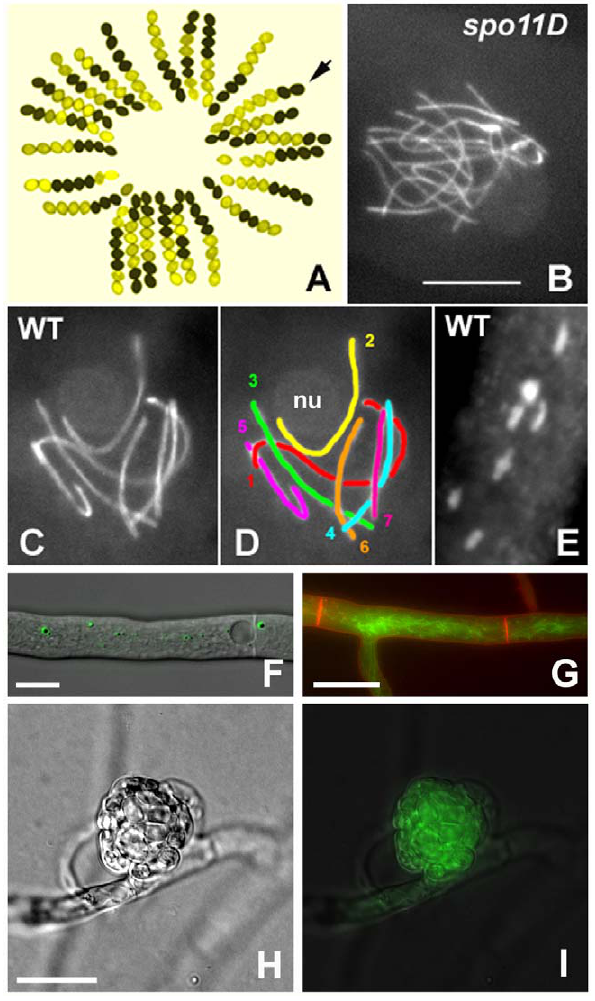
Figure 1. S.macrospora as a model organism for the analysis of meiosis and fruiting body development. (A) Segregation of the ascospore-color mutant pam2 from a cross; wild type (black ascospores) by pam2 (yellow ascospores). Arrow points to a gene conversion indicated by two black and six yellow ascospores. (B–D) Meiotic prophase. Chromosome axes are stained by the cohesin-associated Spo76/Pds5 protein tagged with GFP. (B) Prophase nucleus of a spo11 null mutant: the 14 chromosomes do not align or synapse and this asynaptic status is seen from leptotene through pachytene. (C, D) Pachytene nucleus from wild-type Sordaria: the seven bivalents are differentiated by their size (D). Chromosome 2 (yellow), which bears the nucleolar organizing region, is attached to the nucleolus (nu). (E) The seven bivalents at late diplotene, stained by DAPI. Note the difference in size when compared to the pachytene nucleus. Bar (B–E)=5 m m. (F) An EGFP-HEX1 fusion protein localizes to Woronin bodies. Bar=10 m m. (G) The GFP-tagged developmental protein PRO41 localizes to the endoplasmic reticulum. Plasma membrane stained with FM4-64. Bar=10 m m. (H, I) In a young protoperithecium (H), the GFP-tagged developmentally induced protein APP accumulates (I). Bar=20 m m.